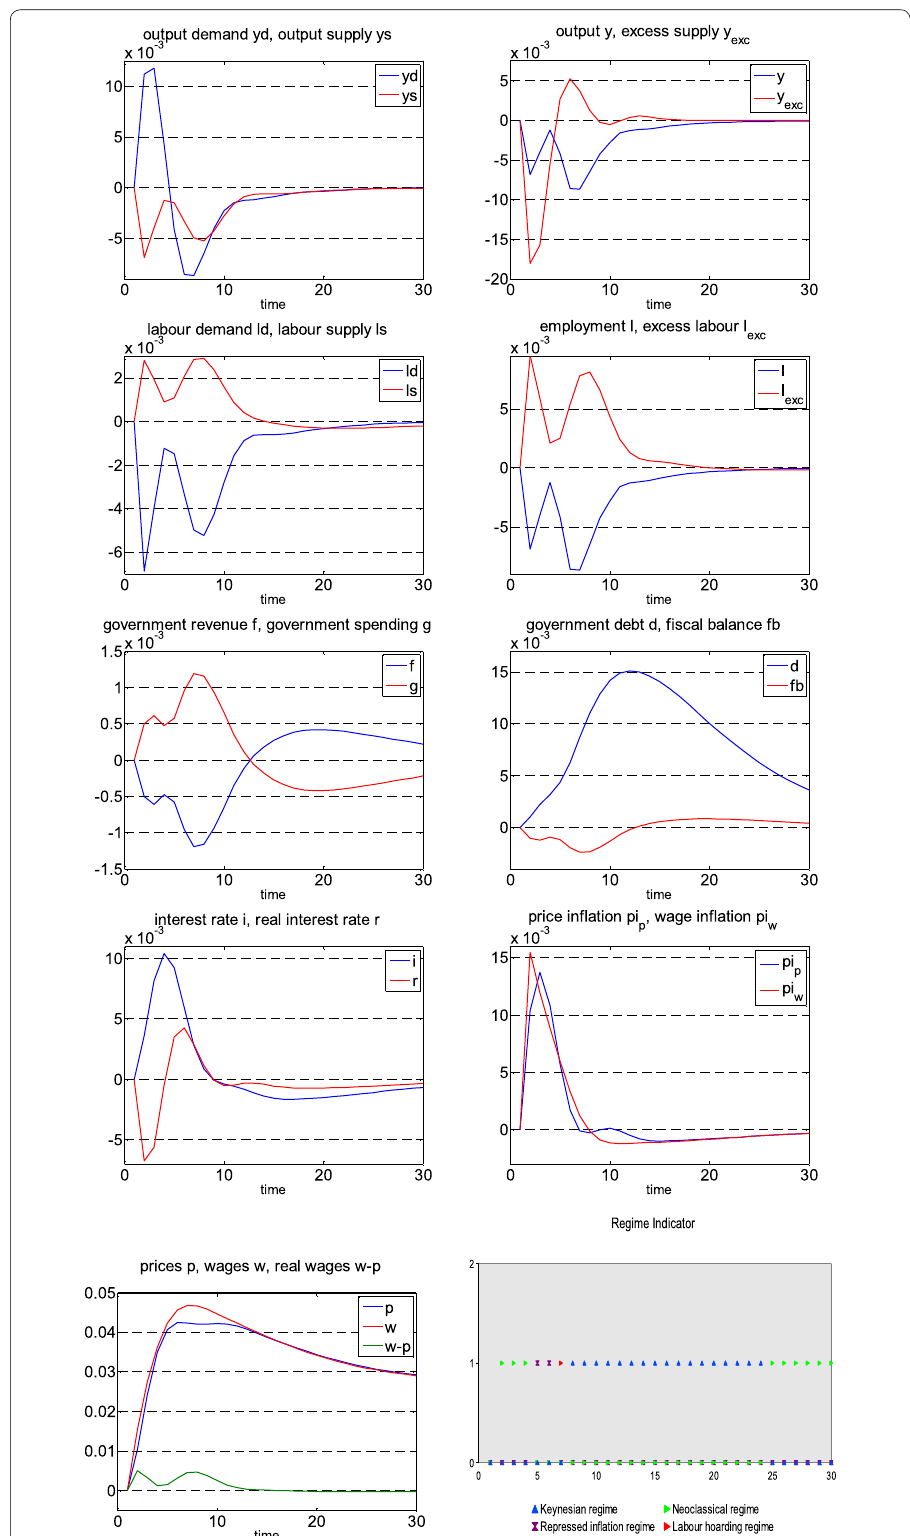
Fig. 3 Effects of a one-time positive wage